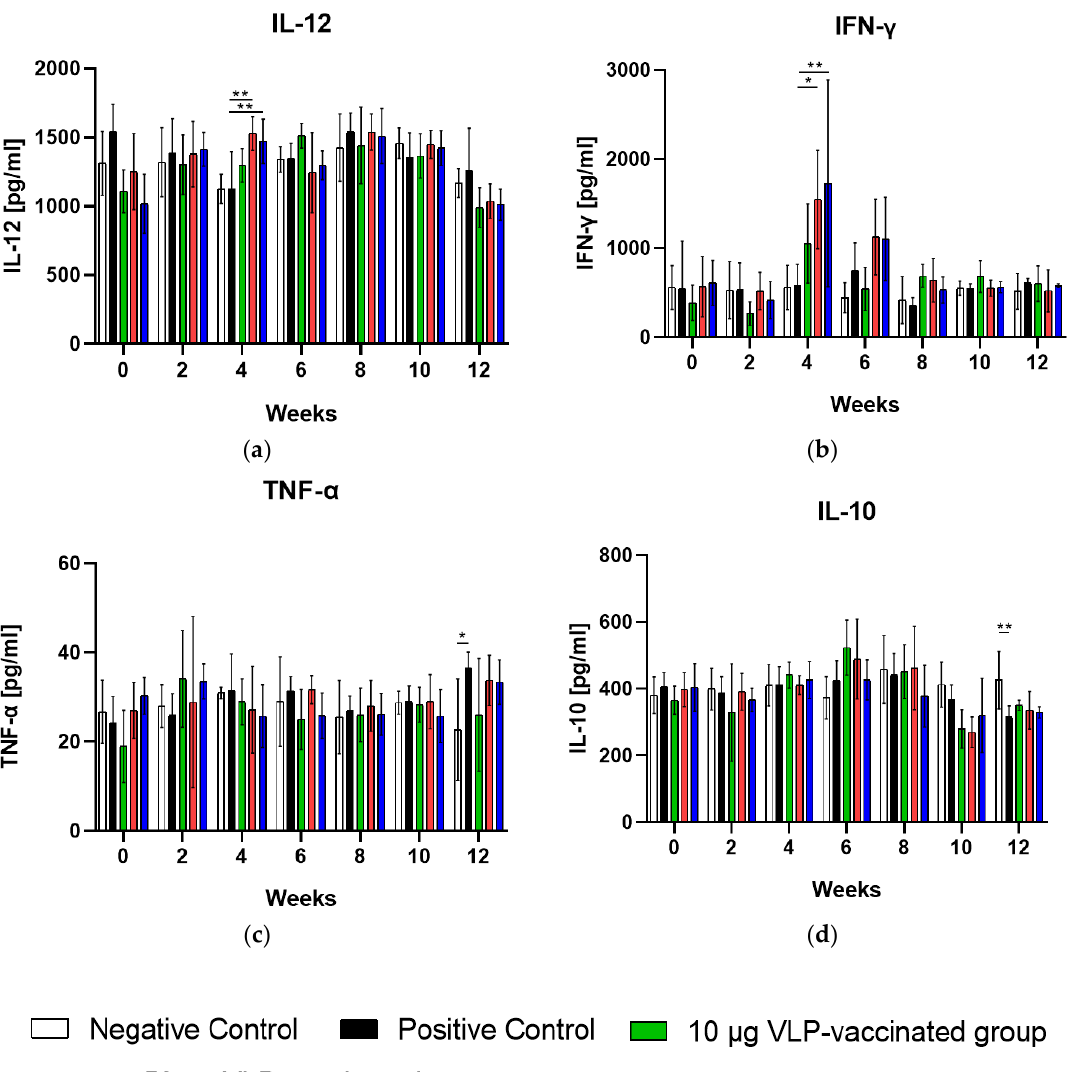
Figure 3. Serum IL-12, IFN- γ , TNF- α , and IL-10 levels were measured in all rabbits every two weeks. ( a ) Serum IL-12 levels of rabbits vaccinated with 50 and 100 µ g VLP were significantly higher ( p < 0.01) than those of the positive control rabbits at week 4. ( b ) Serum IFN- γ levels of rabbits vaccinated with 50 ( p < 0.05) and 100 µ g VLP ( p < 0.01) were also significantly higher than those of the positive control rabbits at week 4. ( c ) Serum TNF- α levels were not significantly changed between the vaccinated and positive rabbits during the experimental periods. ( d ) Serum IL-10 levels were not significantly changed between the vaccinated and positive rabbits during the experimental periods. Differences were compared between the negative and positive control rabbits and between the positive control and vaccinated rabbits. * p < 0.05, ** p < 0.01.